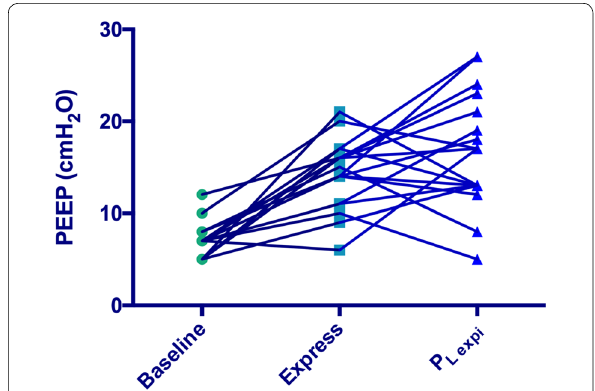
Fig. 1 Individual PEEP levels according to the Express or P Lexpi protocol. PEEP increased from baseline but is individually different for almost all patients with each protocol Express or P